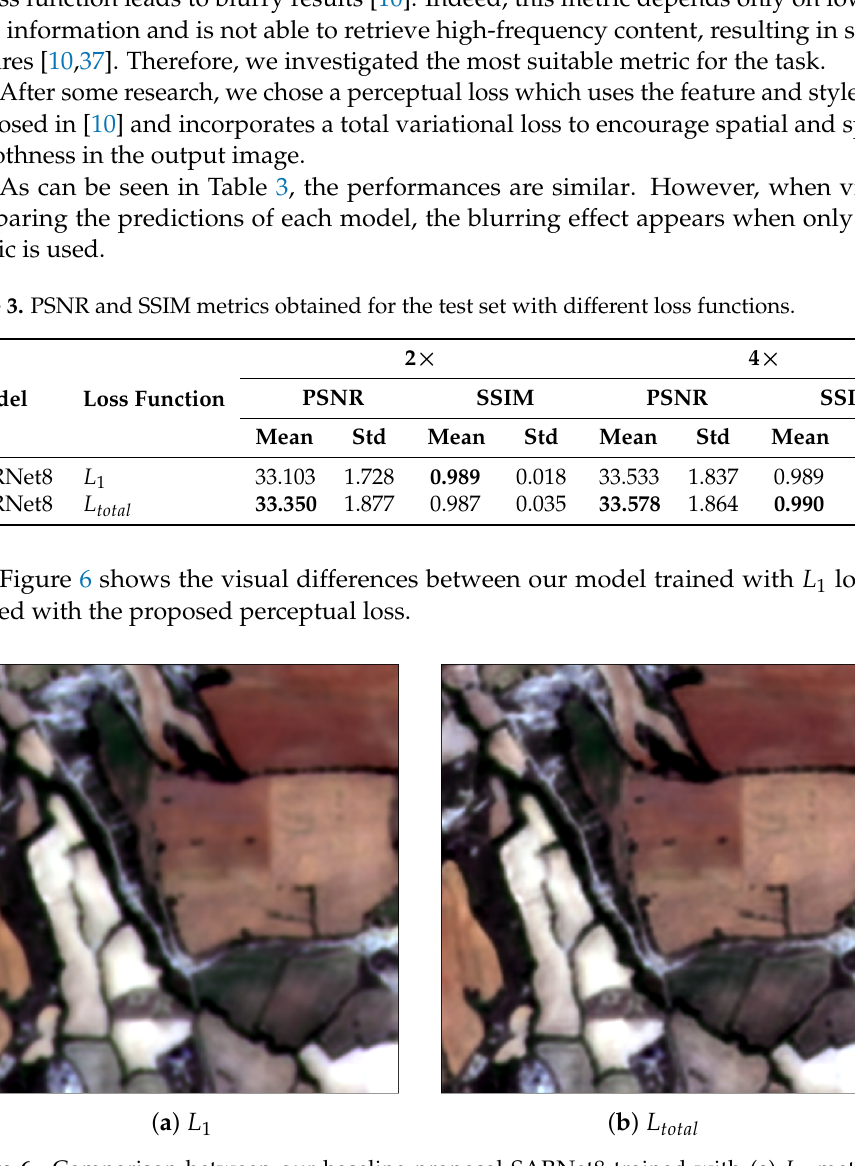
Figure 6. Comparison between our baseline proposal SARNet8 trained with ( a ) L 1 metric and ( b ) L total metric. The results obtained with the second approach are